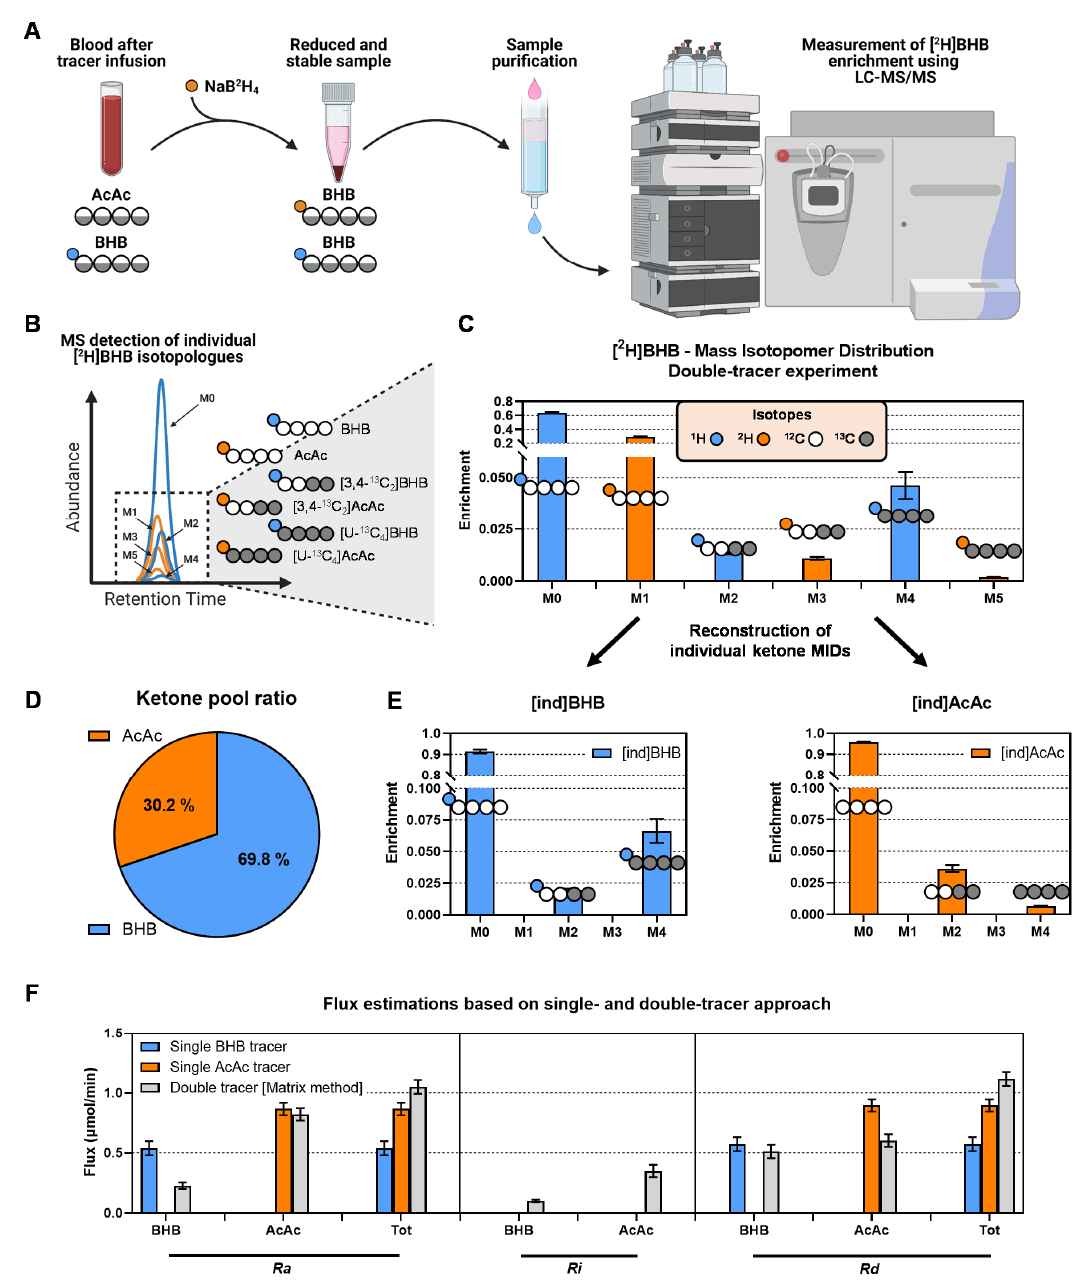
Figure 3. Measurement of ketone enrichment using LC-MS/MS and flux analysis using single- and double-tracer approaches. ( A ) In situ reduction of AcAc by NaB 2 H 4 forms deuterium-labeled BHB, which preserves unstable AcAc isotopologues as BHB isotopologues with one additional mass unit. ( B ) The combined BHB can be detected using LC-MS/MS and contains isotopologues from BHB (not shifted) and AcAc (shifted by M+1). ( C ) [ 2 H]BHB MID—all even isotopologues of BHB after sample preparation are derived from plasma BHB, while all odd isotopologues are derived from plasma AcAc. The MID was corrected for natural abundance using theoretical distributions. ( D ) Odd and even BHB isotopologues encode additional information about relative pool sizes of AcAc and BHB. ( E ) The individual labeling of BHB ([ind]BHB) and AcAc ([ind]AcAc) can be recreated from the odd and even BHB isotopologues of the analyte. ( F ) Comparison of ketone flux determined by using the information from individual BHB and AcAc tracers or both simultaneously (using matrix method). Fluxes were estimated in 14-week-old mice that were fasted for 18-h.